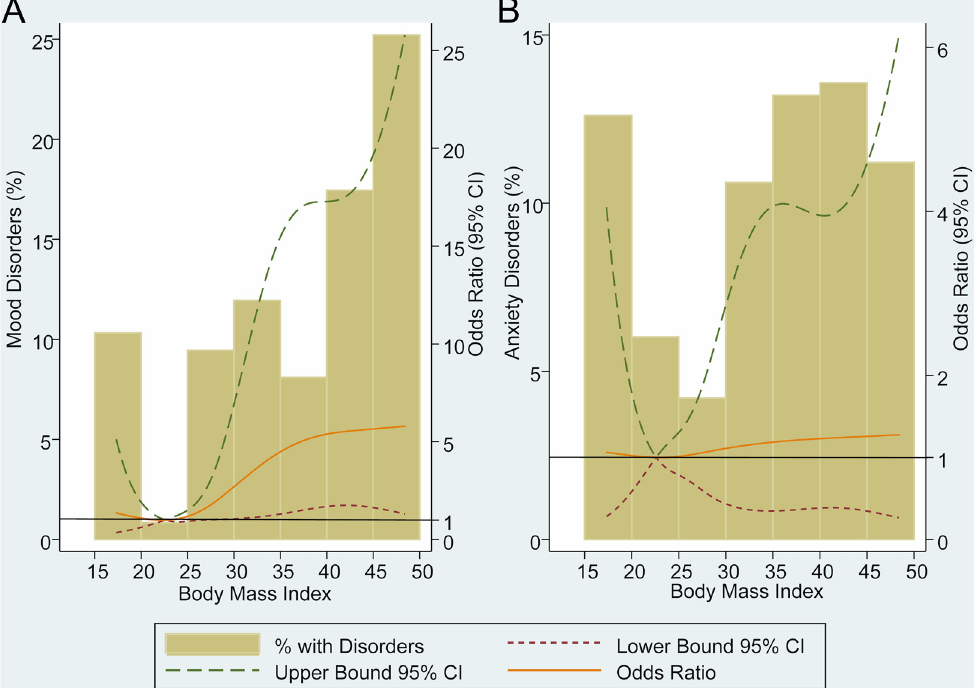
Fig 1. Adjusted odds ratio and percentage of mood and anxiety disorders across the continuum of BMI. (A) Adjusted by age, gender, origin, educational level, family history of psychiatric disease and eating disorders; (B) Adjusted by age, gender, live alone, paid work, origin, family history of obesity, family history of psychiatric disease, substance-related disorders, eating disorder and cluster C personality disorders; CI = confidence